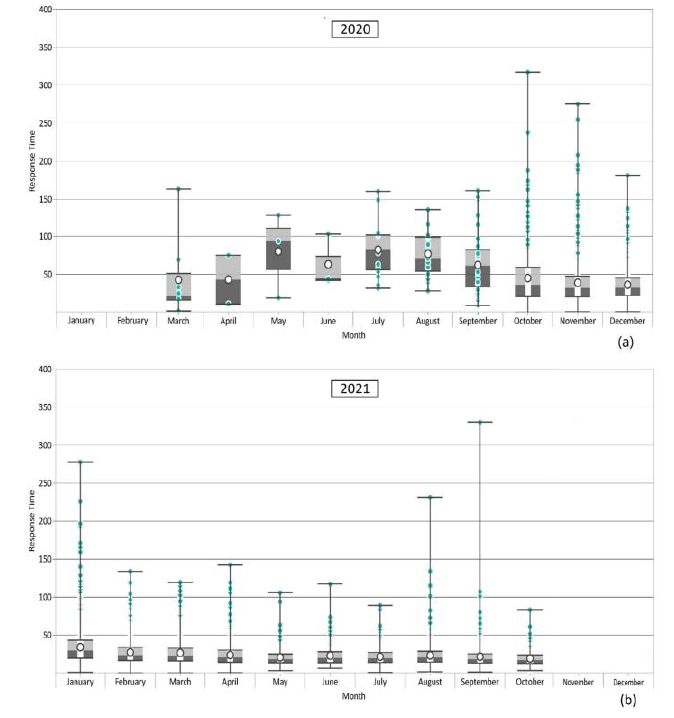
Fig. 8. RT box and plot for Emergency COVID-19 Missions: (a) 2020; (b)